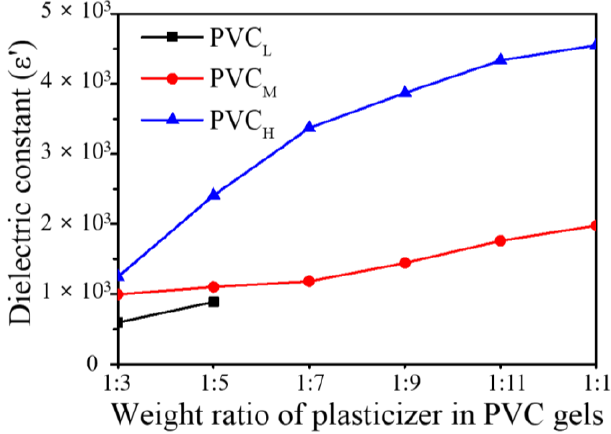
Figure 7. Dielectric constants of the PVC gels at 1 Hz.